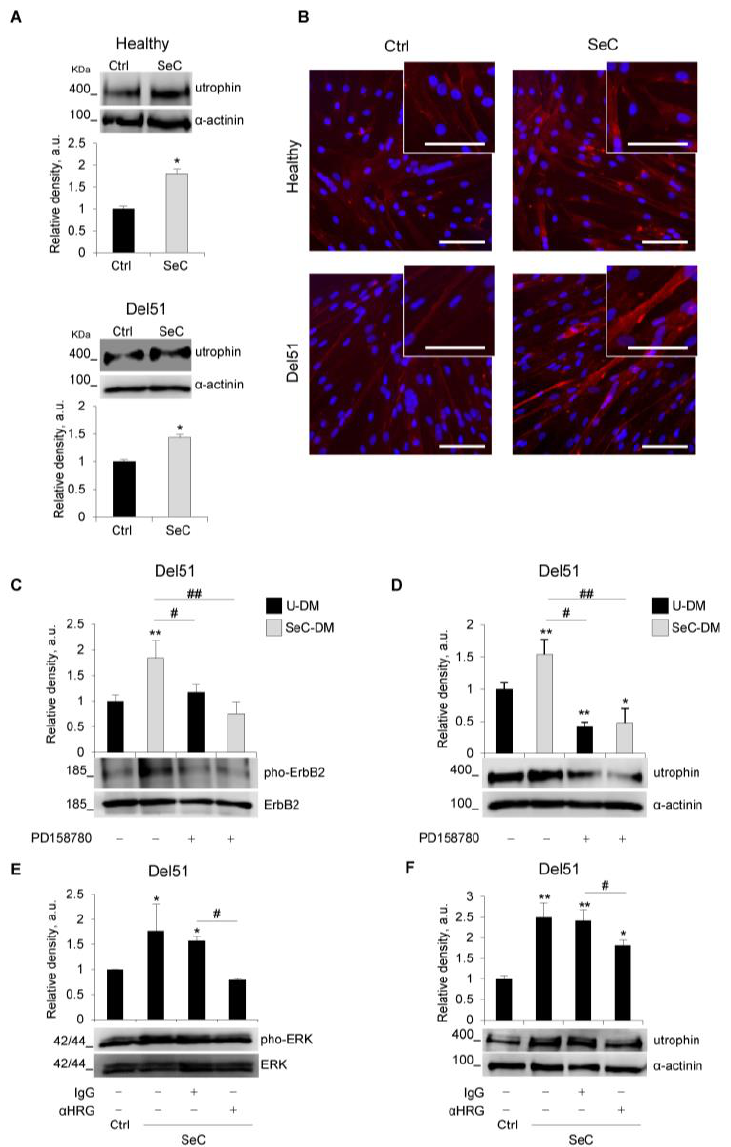
Figure 7. SeC up-regulate utrophin expression in human healthy and DMD myotubes. ( A – F ) Human myotubes obtained by culturing myoblasts derived from healthy donor or Del51 patient in differentiation medium for 4 days were co-cultured in the absence (Ctrl) or presence of SeC (2.0 × 10 5 SeC/mL) using 0.4 µ m transwells ( A , B , E , F ), or cultured in SeC-conditioned (SeC-DM) or unconditioned (U-DM) differentiation medium ( C , D ). ( A ) After 48 h, myotubes were lysed and analyzed for utrophin expression by WB. The average relative densities of utrophin bands with respect to α -actinin bands are reported. ( B ) Immunofluorescence analysis for utrophin (red) expression was performed at 48 h, and DAPI (blue) was used to counterstain nuclei. ( C , D ) Myotubes were cultured with SeC-DM or U-DM for 24 h in the absence or presence of the ErbB receptor tyrosine kinase inhibitor, PD158780 (100 nM) or the same amounts of vehicle (DMSO). Myotubes were lysed and utrophin ( C ) and phosphorylated ErbB2 (pho-ErbB2) ( D ) expression were analyzed by WB. The average relative densities of utrophin and pho-ErbB2 bands with respect to α -actinin or total ErbB2 bands, respectively, are reported. ( E , F ) Myotubes co-cultured with or without SeC were added with either an anti-heregulin β 1 blocking antibody ( α HRG, 2 µ g/mL) or the same amounts of non-immune IgG to the upper chamber of the transwells for 24 h ( E ) or 48 h ( F ). Myotubes were lysed and phosphorylated ERK1/2 (pho-ERK) ( E ) and utrophin ( F ) expression were analyzed by WB. The average relative densities of pho-ERK and utrophin bands with respect to total ERK or α -actinin bands, respectively, are reported. * and **, significantly different from Ctrl or untreated U-DM ( p < 0.05 and p < 0.01, respectively). # and ##, significantly different ( p < 0.05 and p < 0.01, respectively). Reported are representative images ( A – F ). Results are means ( ± SD) of three independent experiments. Scale bars ( B ), 50 µm.